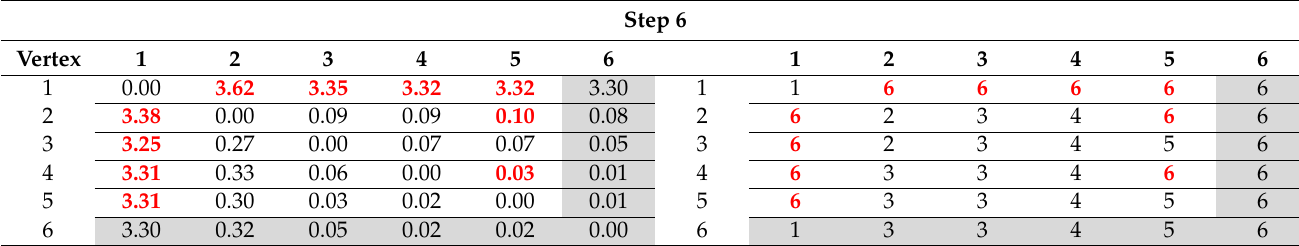
Table A15. The step 6 graphical process of the best search and rescue